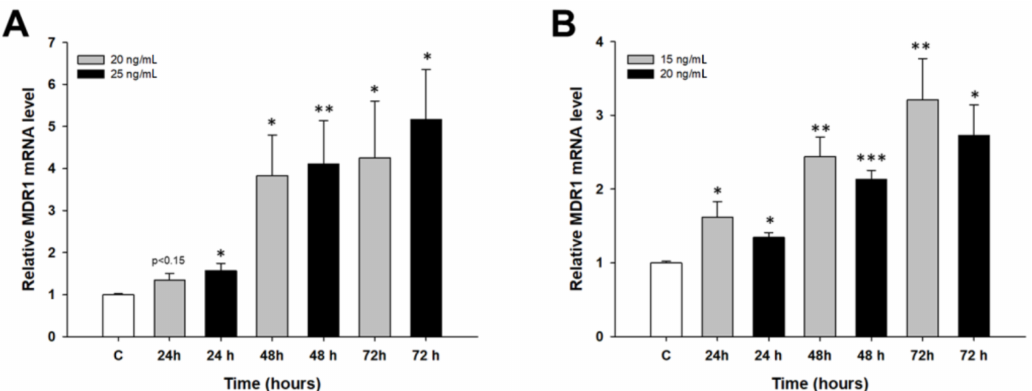
Figure 5. Expression analysis of the MDR1 gene in the A2780 ( A ) and W1 ( B ) cell lines. The figure presents the relative gene expression in the PAC-treated cells (grey and black bars) with respect to that in the untreated control (white bars), which was assigned a value of 1. The values were considered significant at * p < 0.05, ** p < 0.01 and *** p <